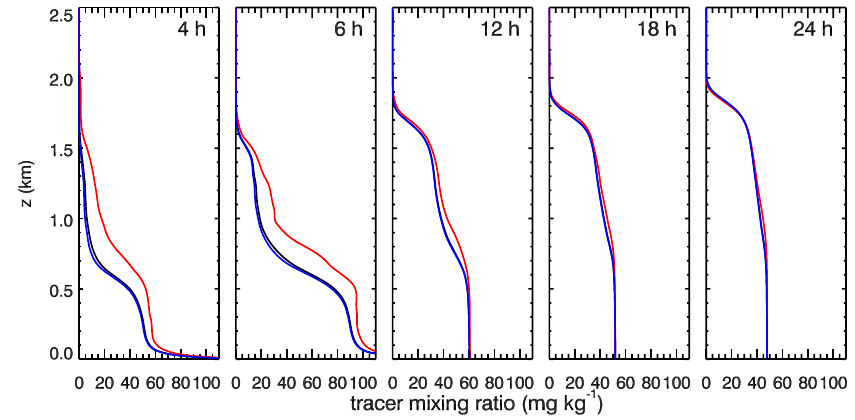
Fig. 1. Sampled profiles of tracer mixing ratio for case 1 at various moments. The black, red and blue lines represent profiles sampled over the whole domain, cloudy columns (liquid water path > 10gm − 2 ) , and cloud-free columns, respectively in case